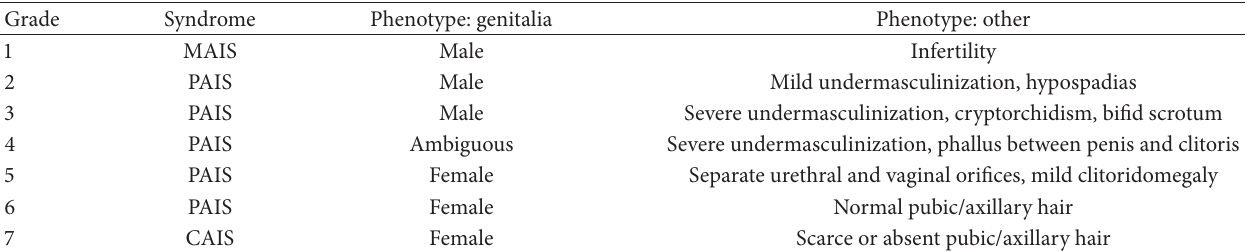
Table 1: Severity of androgen